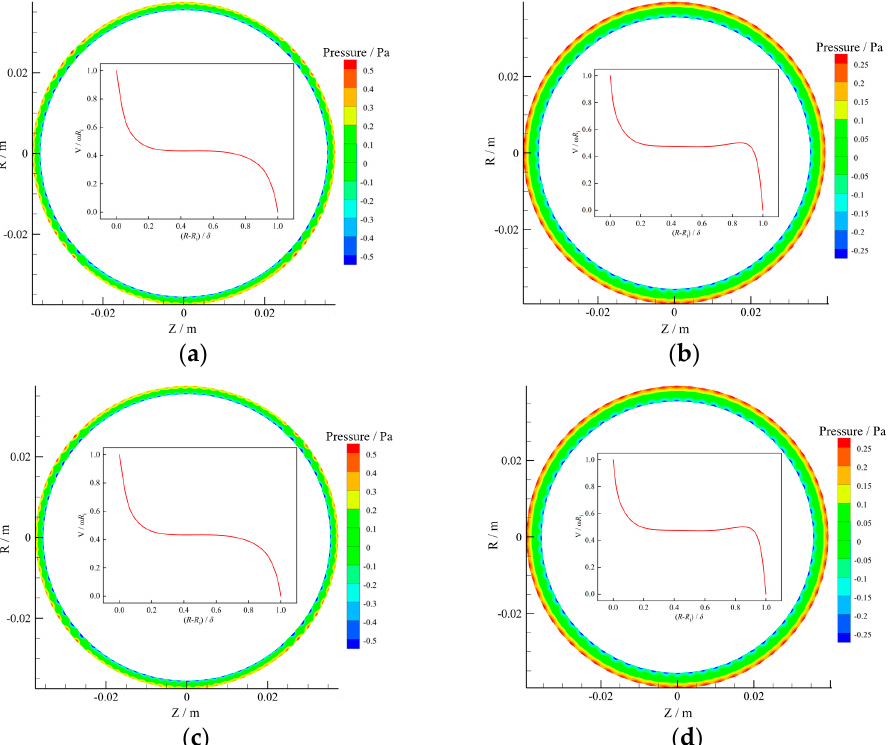
Figure 14. Pressure contours in the tangential direction and velocity distribution in the radial direction for Re = 10 4 ( a ) Case I; ( b ) Case II; ( c ) Case III; ( d ) Case IV.